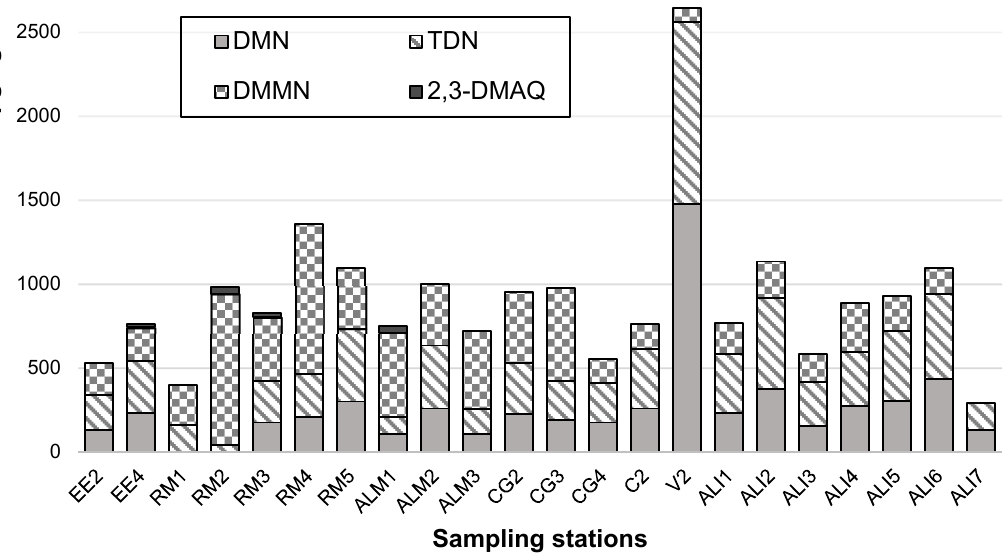
Figure 2. Semi-quantification results for PAH-derivatives: the example of the leaves of P. oceanica . Detections under LOQ were not included in this chart figure.